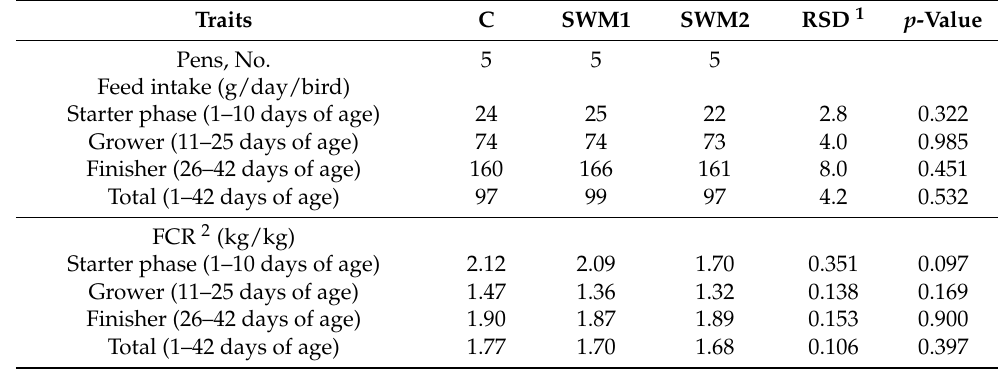
Table 4. Effect of the dietary inclusion either with 0% (Control) or 4% of defatted silkworm ( Bombyx mori L.) meal during starter (SWM1) or grower and finisher (SWM2) phase on broilers feed intake and feed conversion ratio